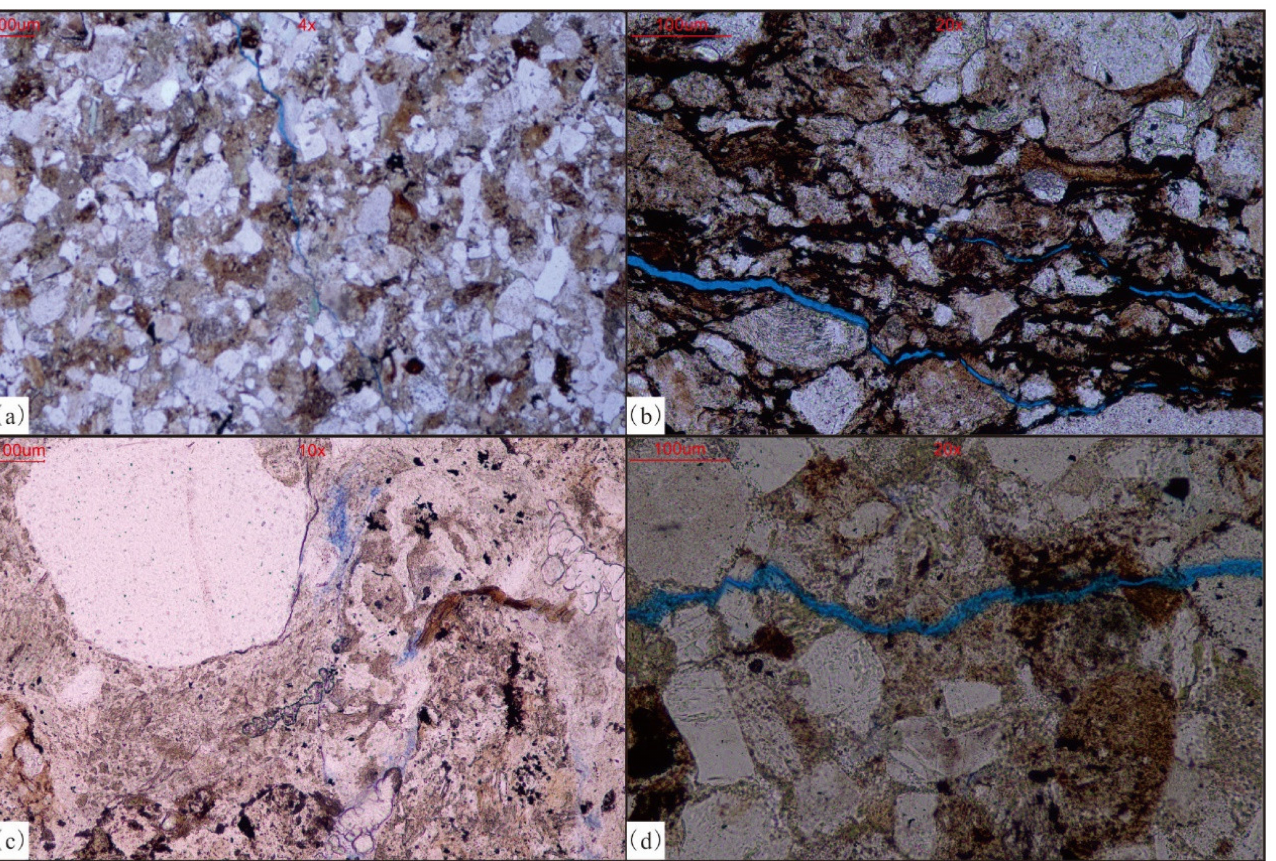
Figure 5. Micro-characteristics of seismite reservoir in the Carboniferous formation of the Shibei sag. ( a ) Well ZB6: well depth 5102.36 m, microfracture; ( b ) Well ZB6: well depth 5107.88 m, microfracture; ( c ) Well ZB6: well depth 5065.40 m, hydration of biotite and dissolution pores; ( d ) Well ZB6: well depth 5102.36 m, microfracture and dissolution